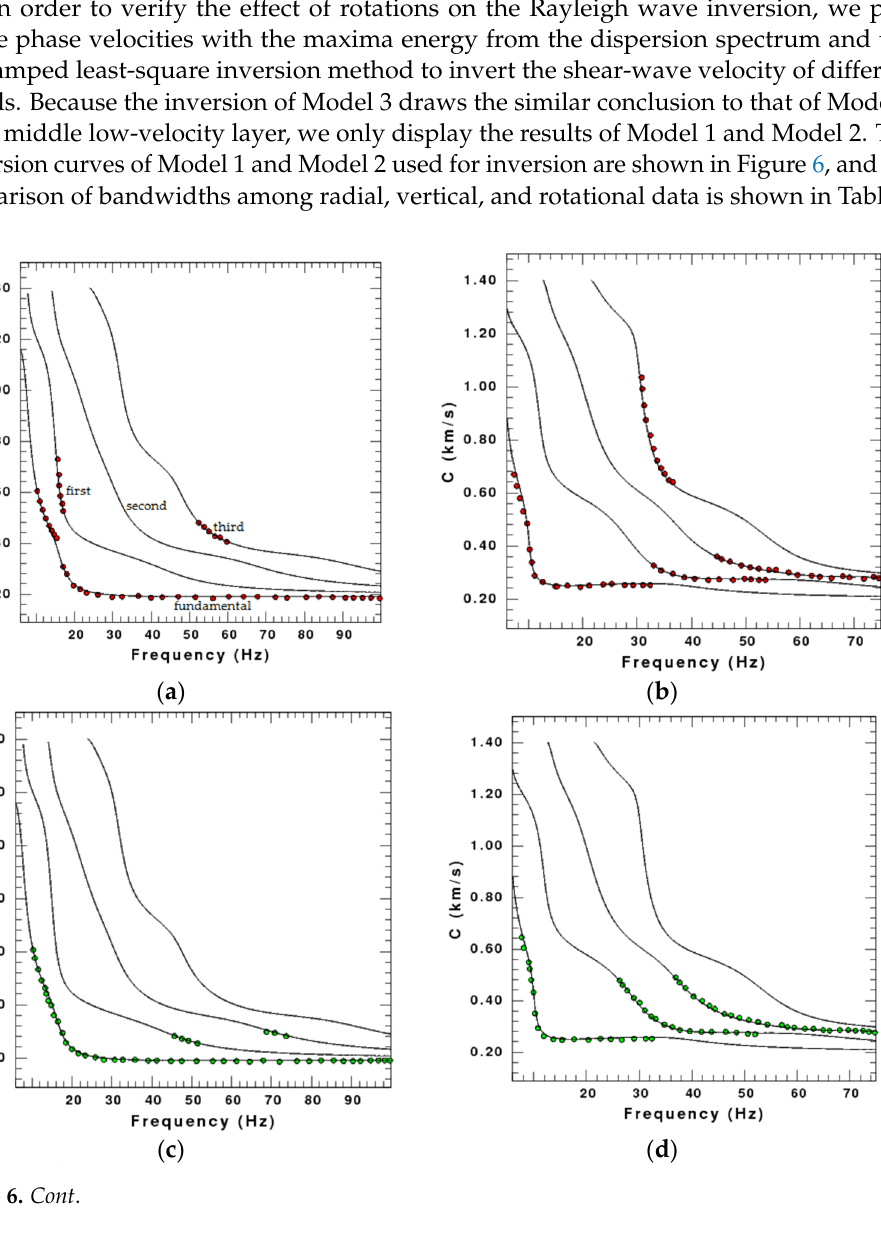
( f ) Figure 6. Dispersion curves for Model 1 and Model 2, where the black lines are the theoretical dis- persion curves and different shapes of points correspond to the different modes. ( a ) X component of Model 1; ( b ) X component of Model 2; ( c ) Z component of Model 1; ( d ) Z component of Model 2; ( e ) R y component of Model 1; ( f ) R y component of Model 2.